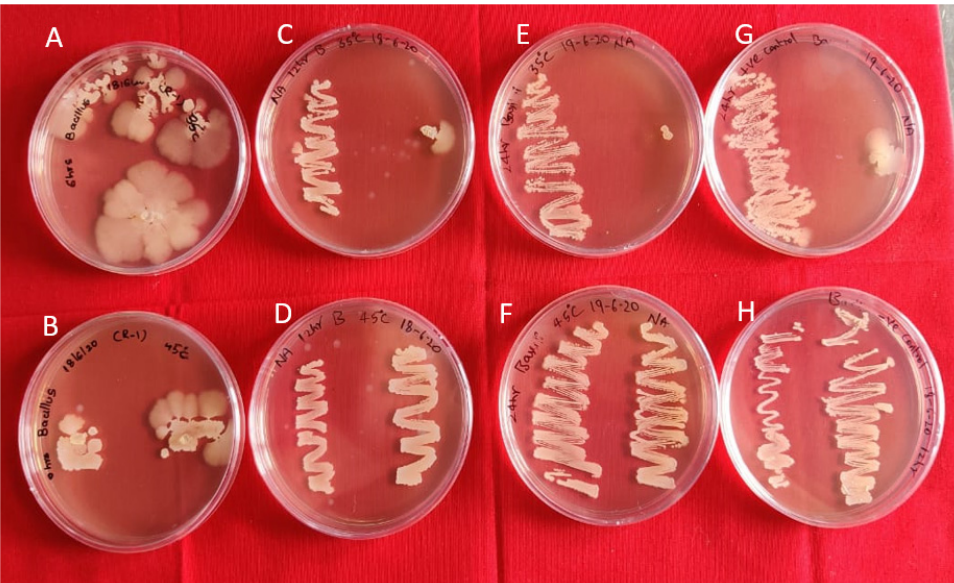
Figure 3. Antifungal activity of Bg_9562 protein and BIK3 colony discs at varied temperatures and incubation periods: ( A , B ) 6 h incubation at 45 °C, 35 °C; ( C , D ) 12 h incubation at 45 °C, 35 °C; ( E , F ) 24 h incubation at 45 °C, 35 °C; ( G ) untreated protein (positive control); ( H ) BIK3 (negative control); no effect of protein on bacterial growth. Observations taken after 24 h.